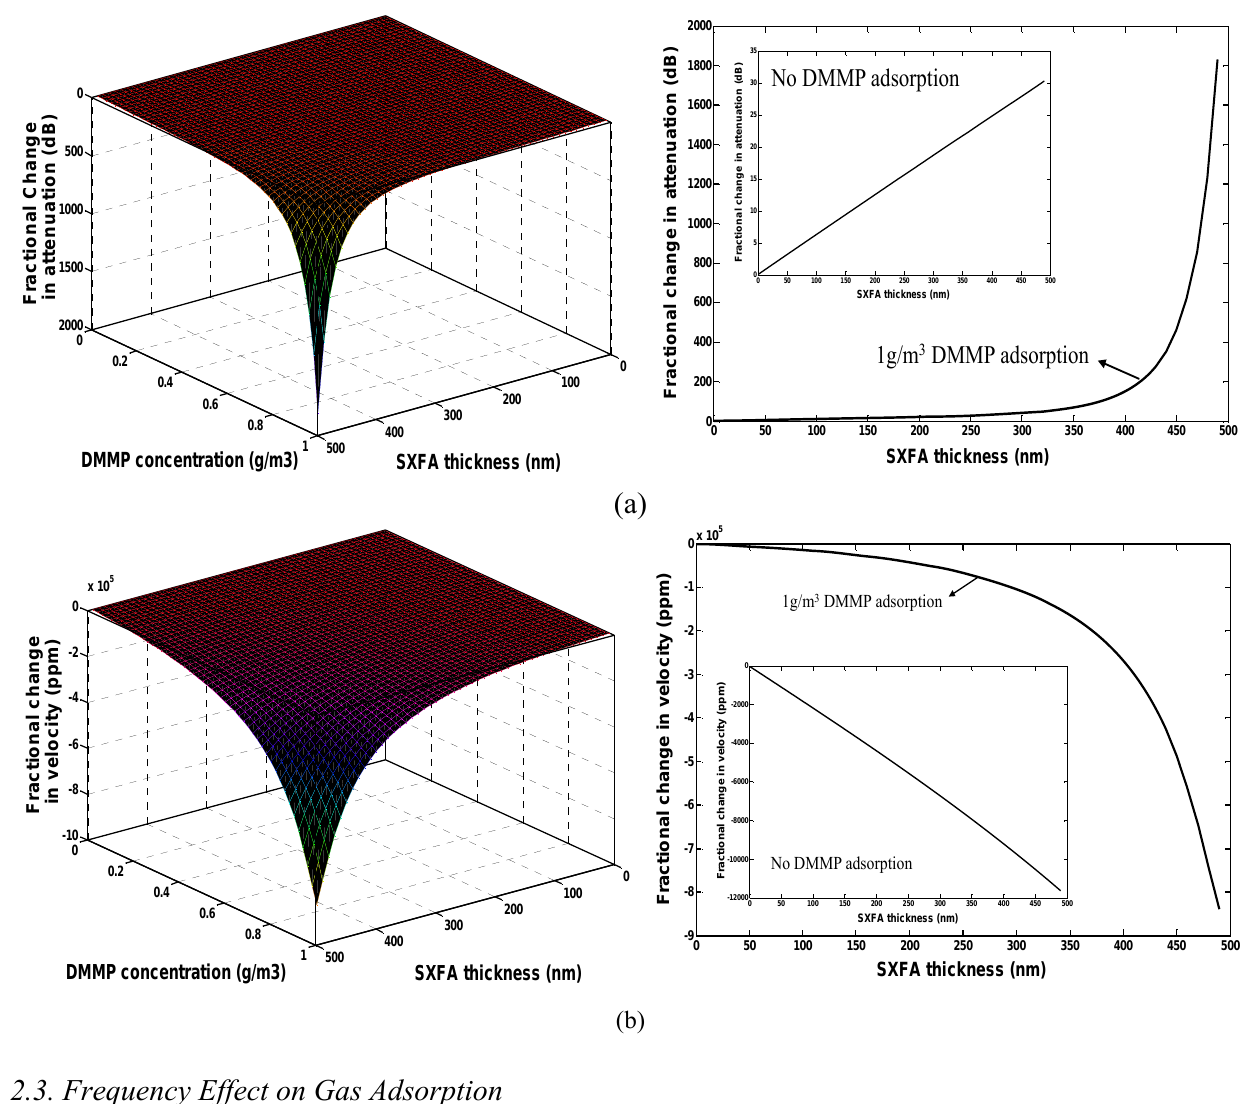
Figure 3. (a) Change in attenuation. (b) Velocity shift from SXFA on vapor